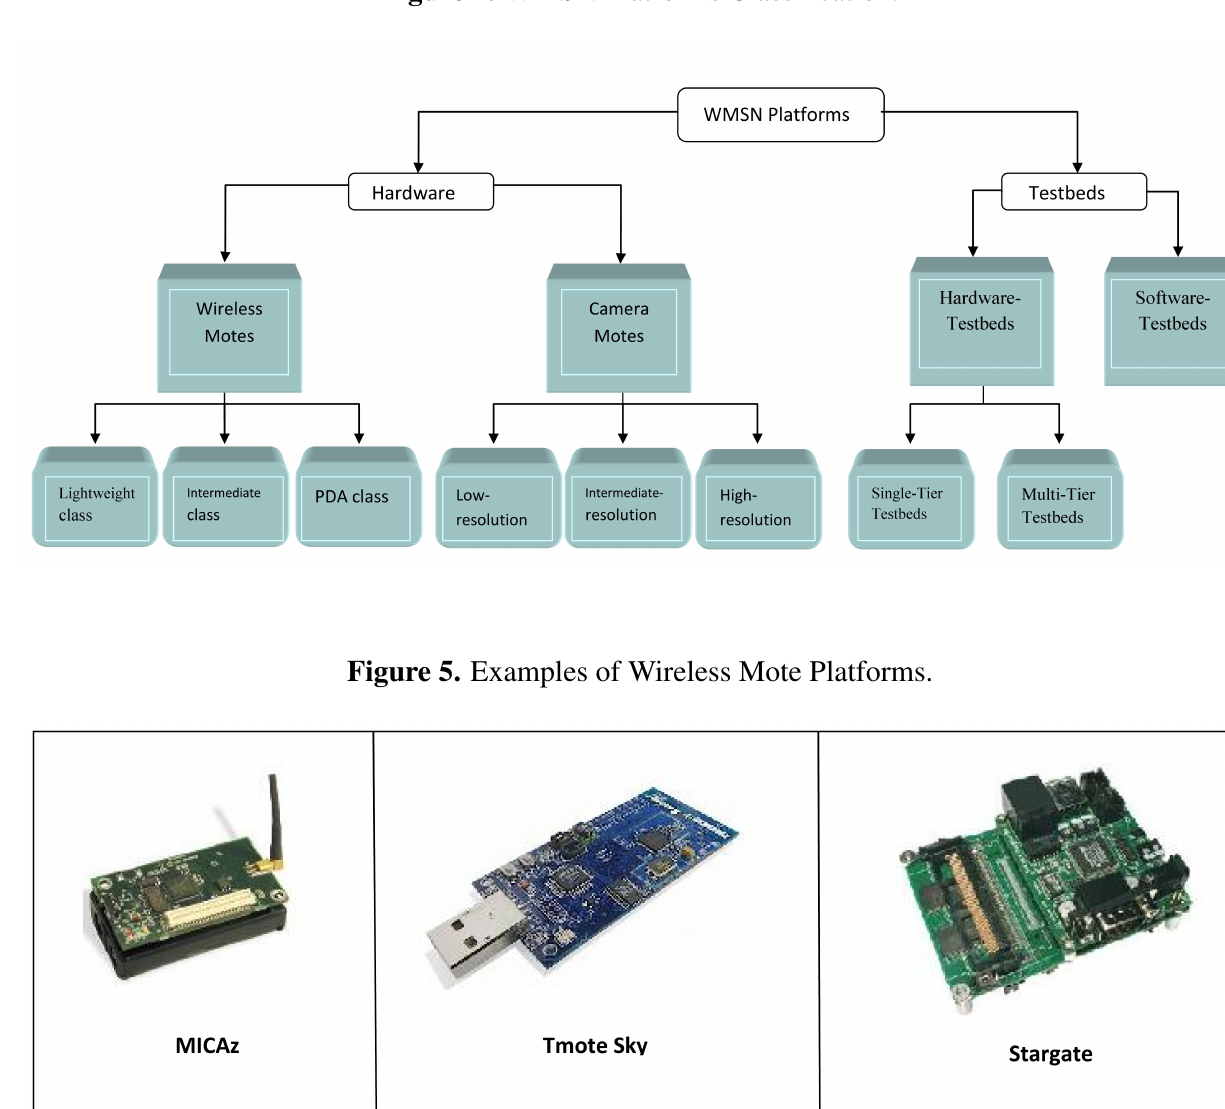
Figure 4. WMSN Platforms Classification.